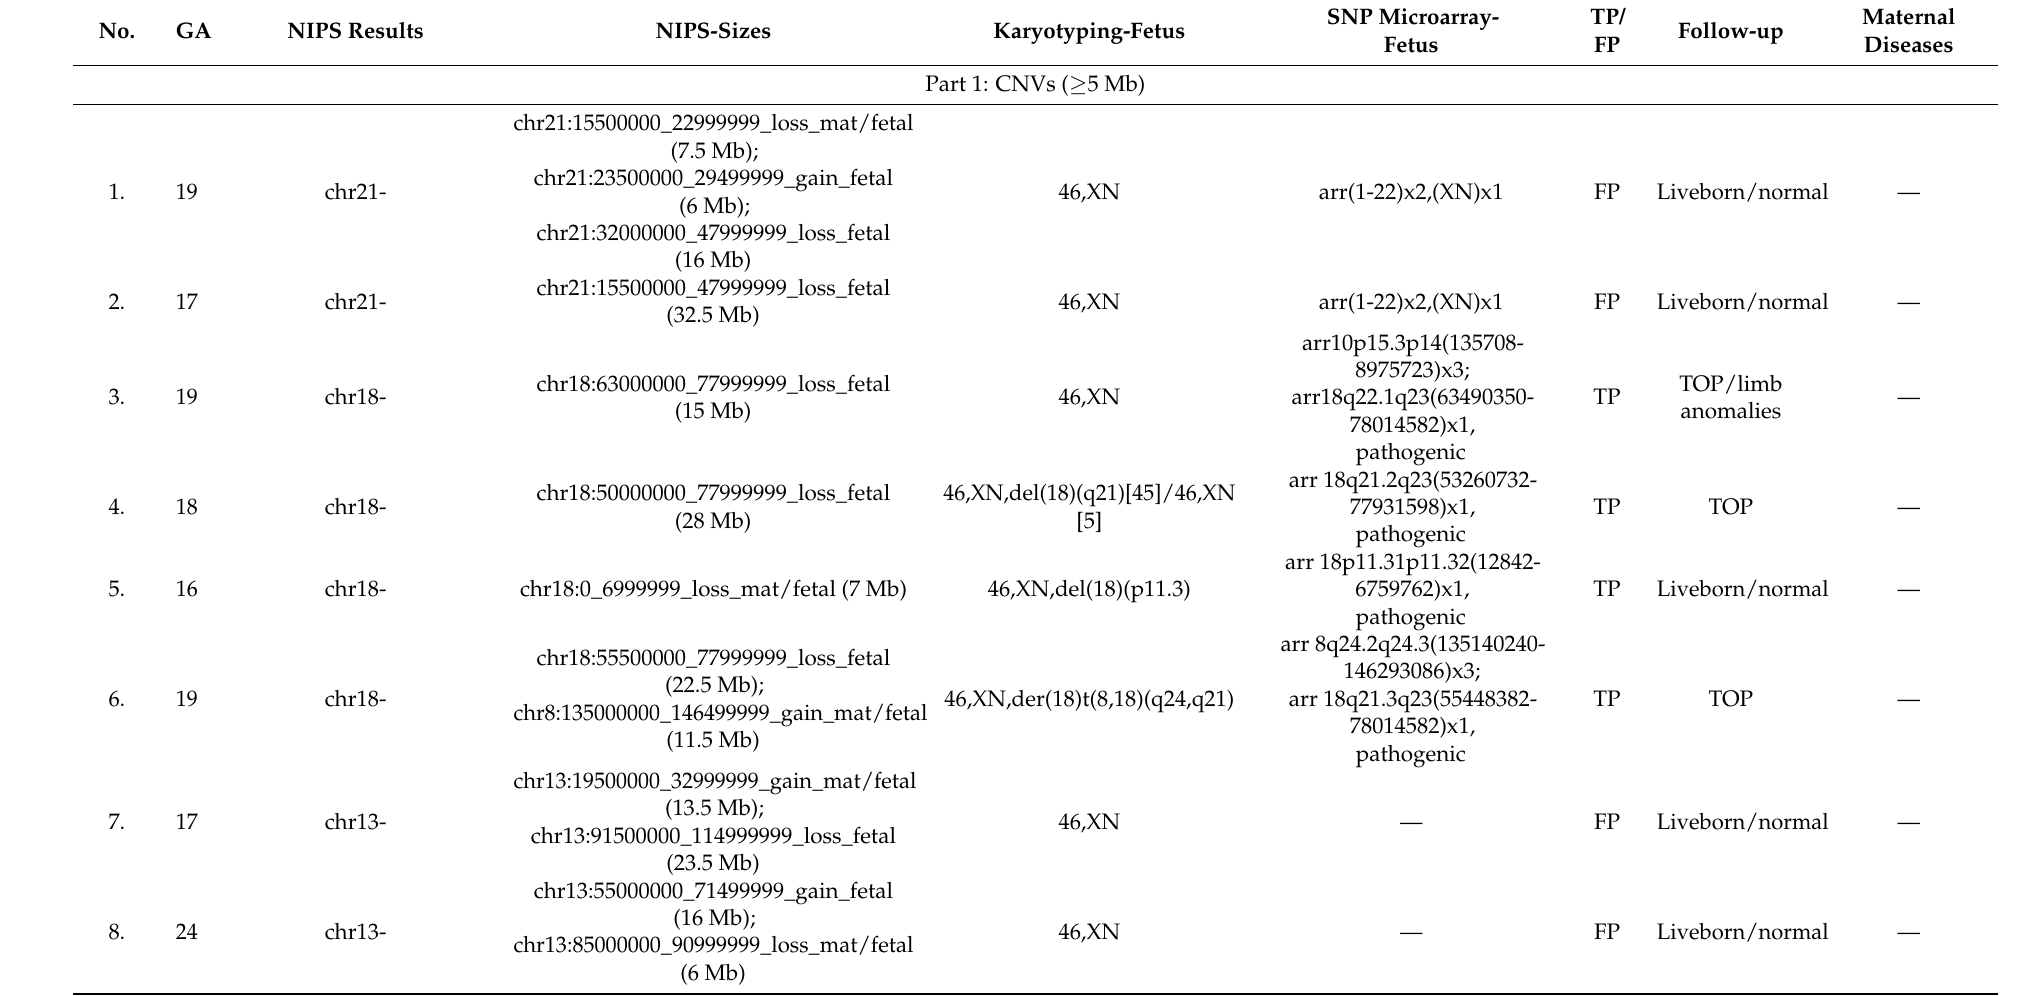
Table A2. Detailed diagnostic information of NIPS–CNVs/RATs results and follow-up